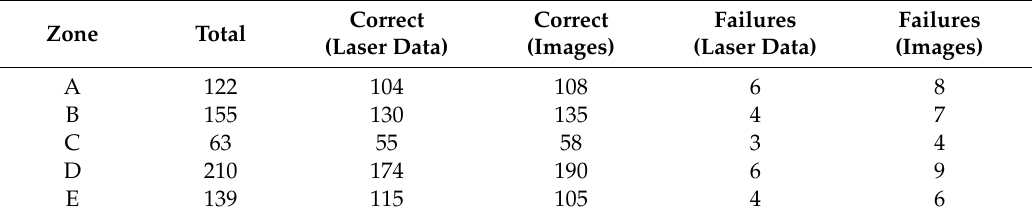
Figure 10. Detection results. ( a ) Sample A. ( b ) Sample B. ( c ) Sample C. ( d ) Sample D. ( e ) Sample E. Table 3. Detection results from the laser data and ground images. Table 3. Detection results from the laser data and ground images.